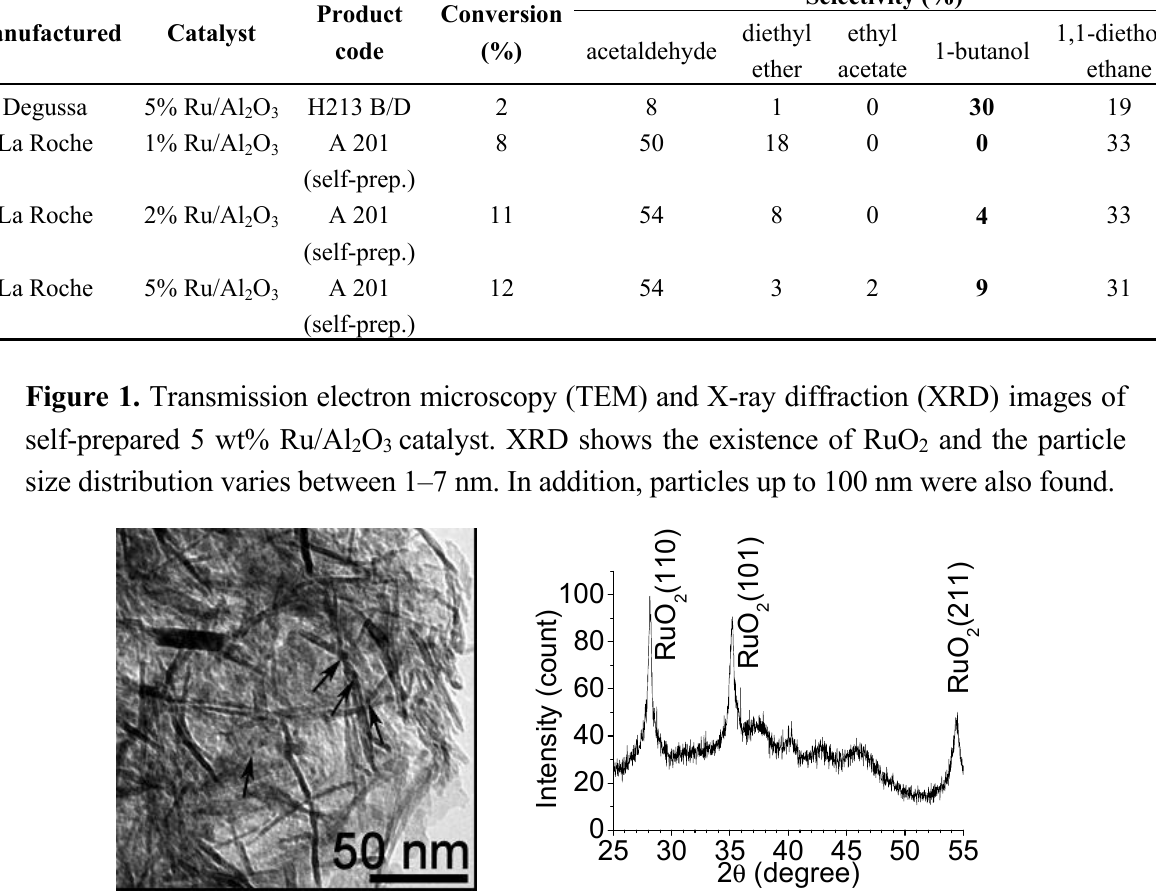
and the particle 2